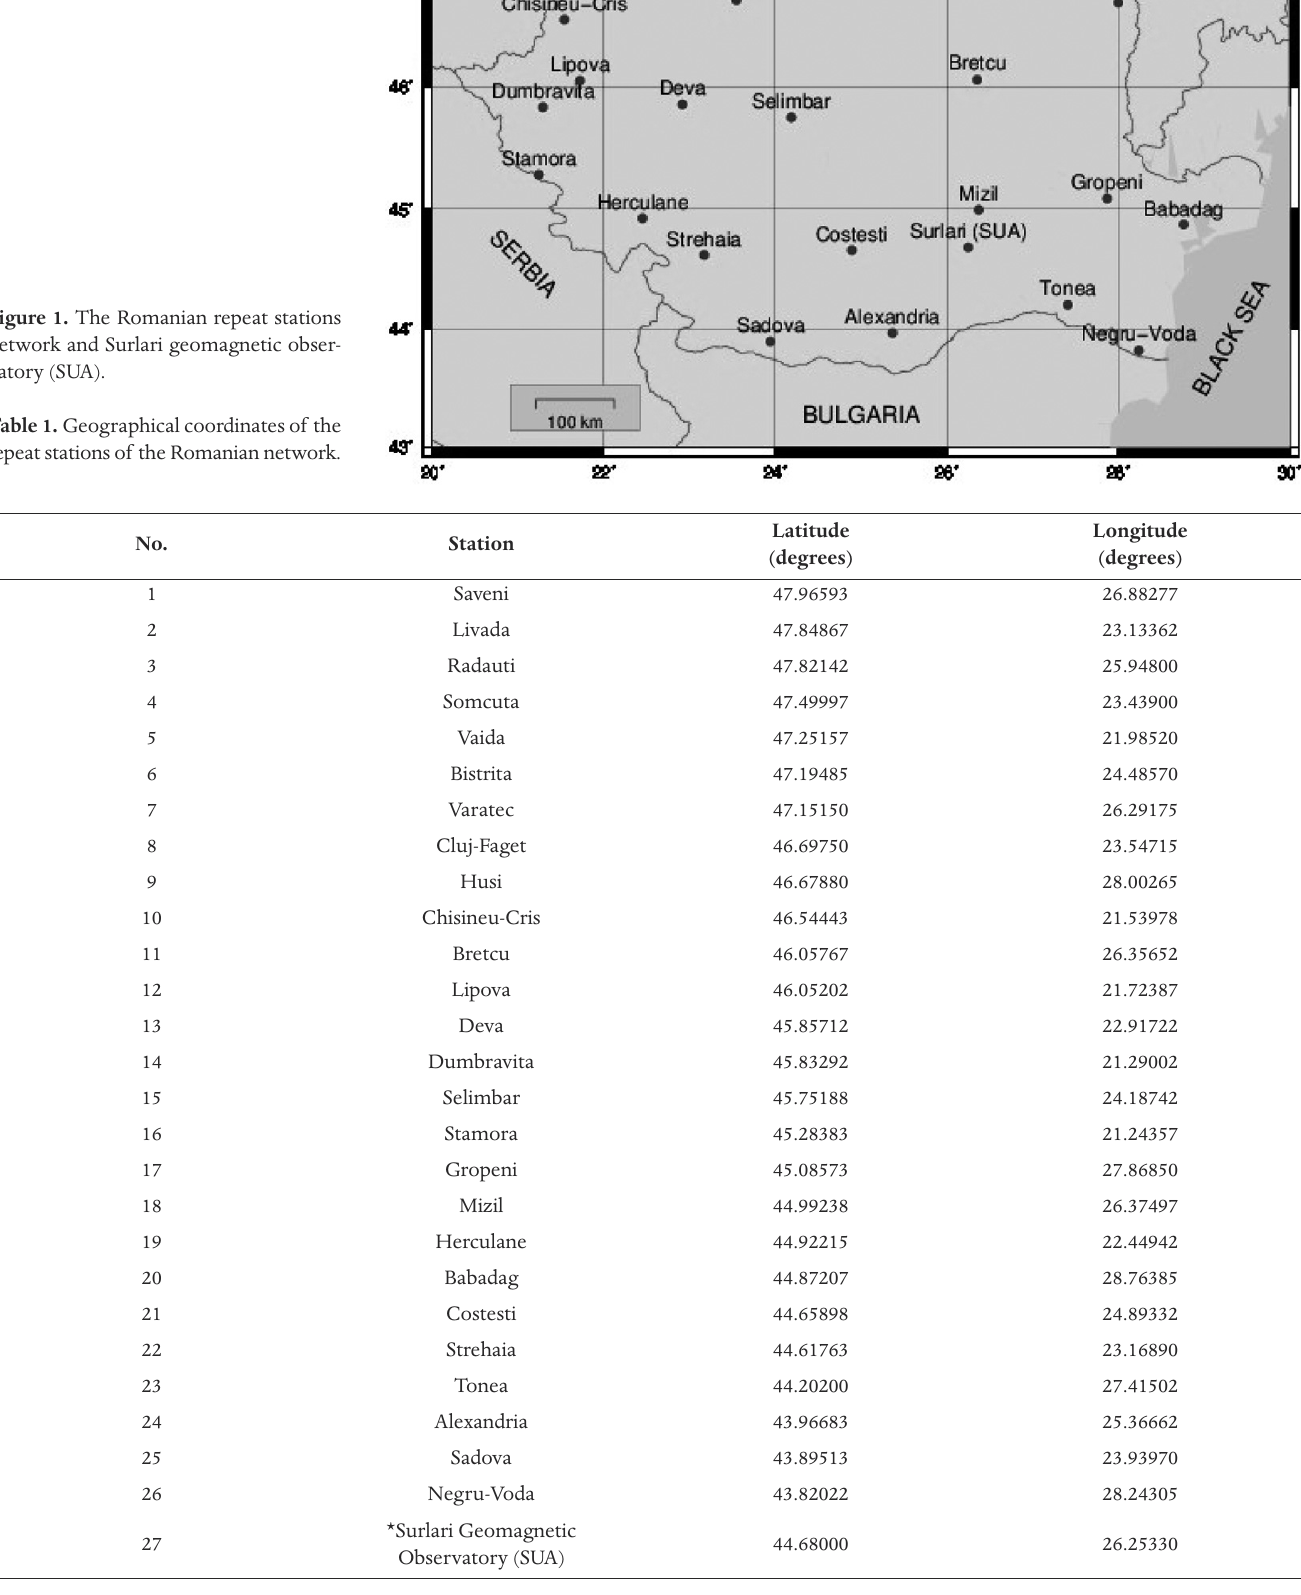
Figure 1. The Romanian repeat stations network and Surlari geomagnetic obser- vatory (SUA). Table 1. Geographical coordinates of the repeat stations of the Romanian